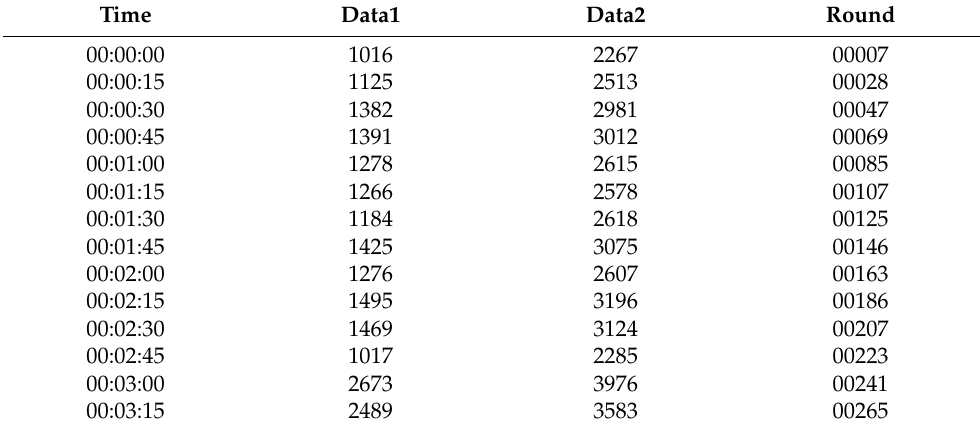
Table 2. Experimental